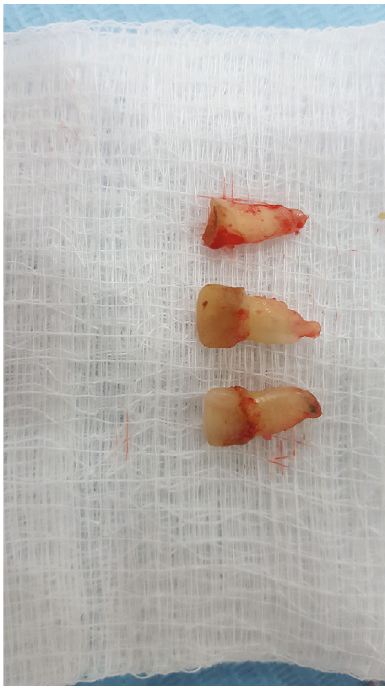
Figure 4: Extracted anterior primary